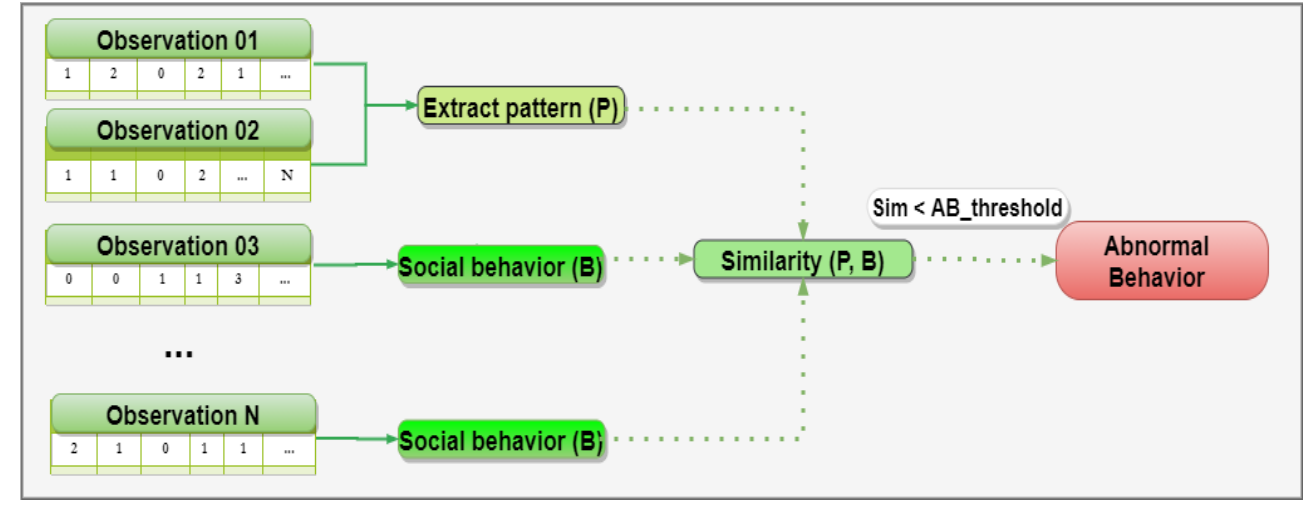
Figure 3. Strategy for detecting abnormal social behavior.